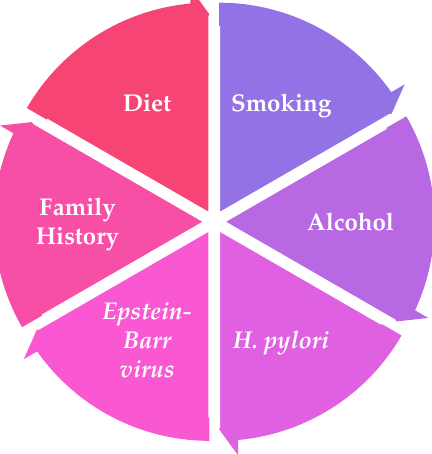
Diagram 1. Risk factors for GC development. Figure 1. Risk factors for GC